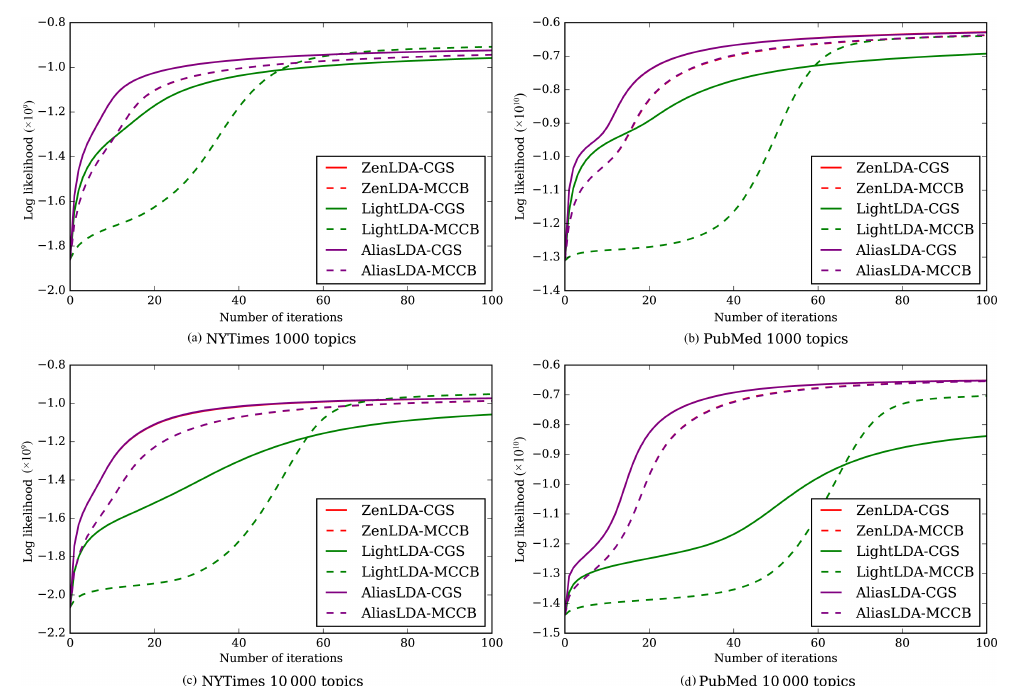
Fig. 6 Log-likelihood comparison between CGS and MCCB. Note that the curves of ZenLDA-CGS/MCCB were almost covered by AliasLDA-CGS/MCCB.